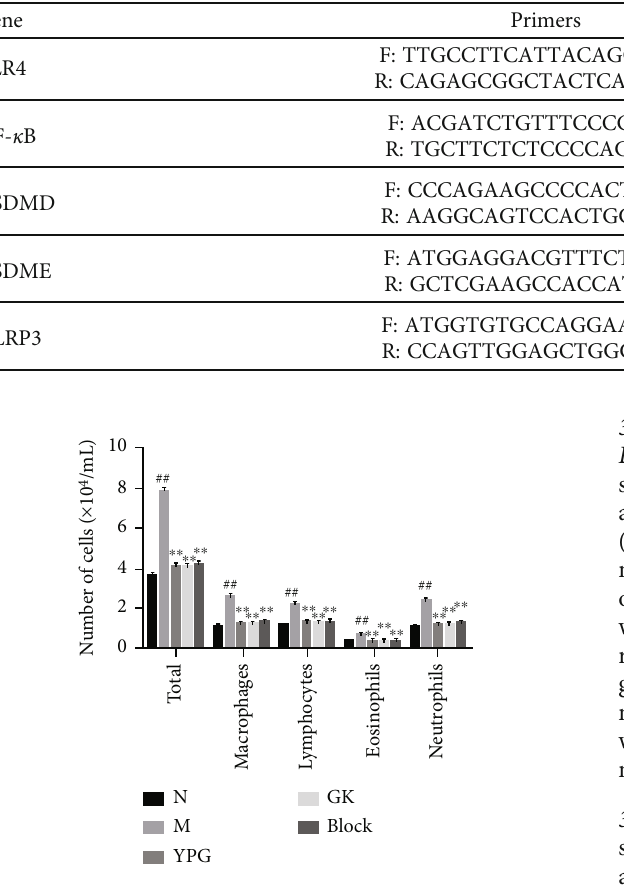
Figure 2: E ff ects of YPG on the number of in fl ammatory cells in BALF. Notes: ## P < 0 : 01 compared with the normal group; ∗∗ P < 0 : 01 compared with the model